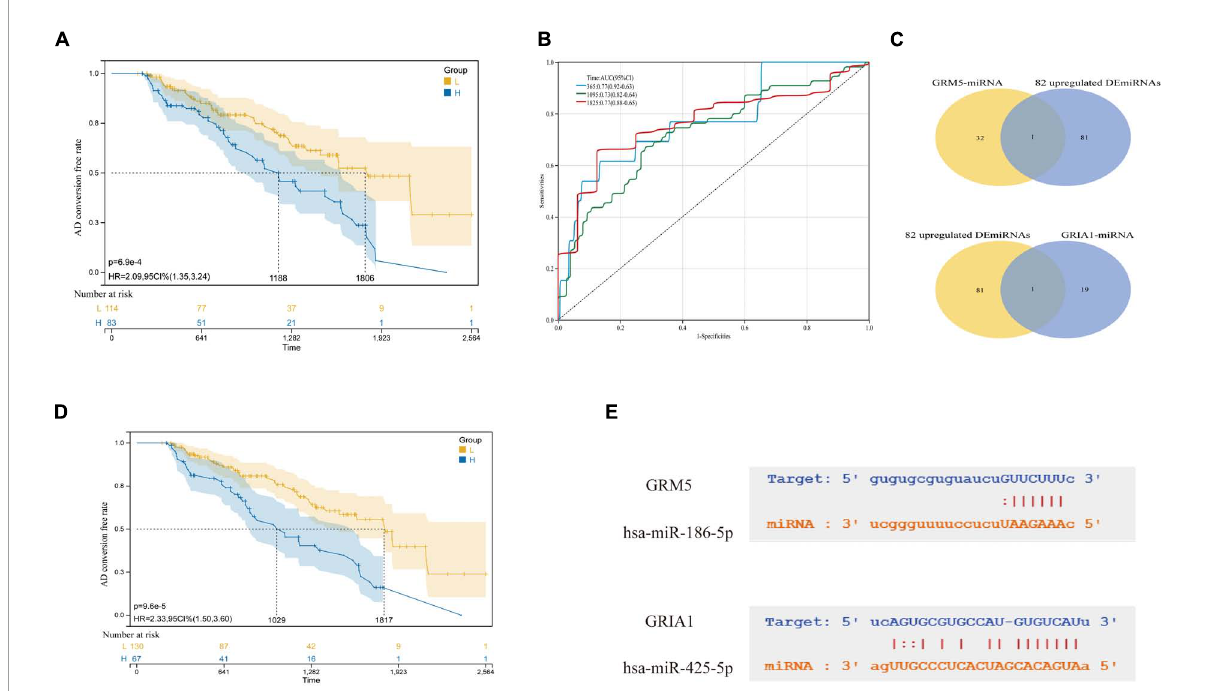
FIGURE8 Selection of key miRNAs. (A) AD conversion curves of hsa-miR-186-5p. (B) ROC analyses for the 365, 1,095, and 1,825 time points were performed using the ROC function of the R package proc (version 1.17.0.1). (C) The intersection of predicted miRNAs and abnormal miRNAs in blood. (D) hsa-miR-425-5p. (E) They are, respectively, the complementary base sequence matching of hsa-miR-186-5p and target gene GRM5, and the complementary base sequence matching of hsa-miR-425-5p and target gene